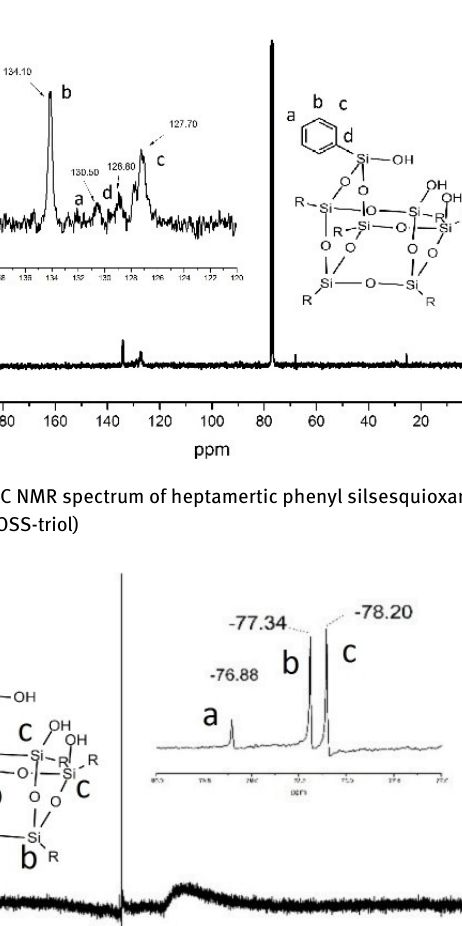
Figure9istheXRDdiagramofwollastoniteanditscompos-